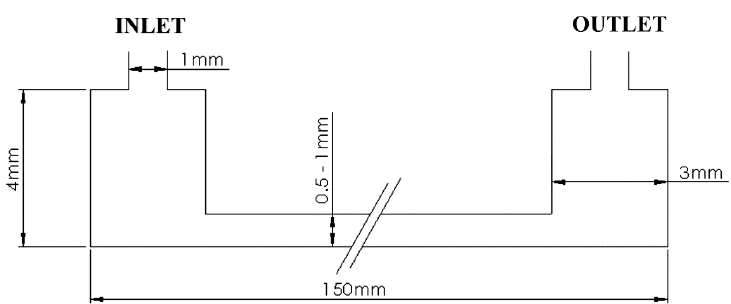
Figure 1. Simplified geometry of rectangular mini-channel.